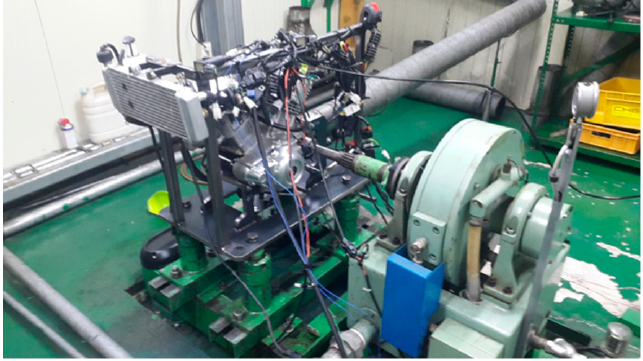
Figure 2. The experiment engine setup system